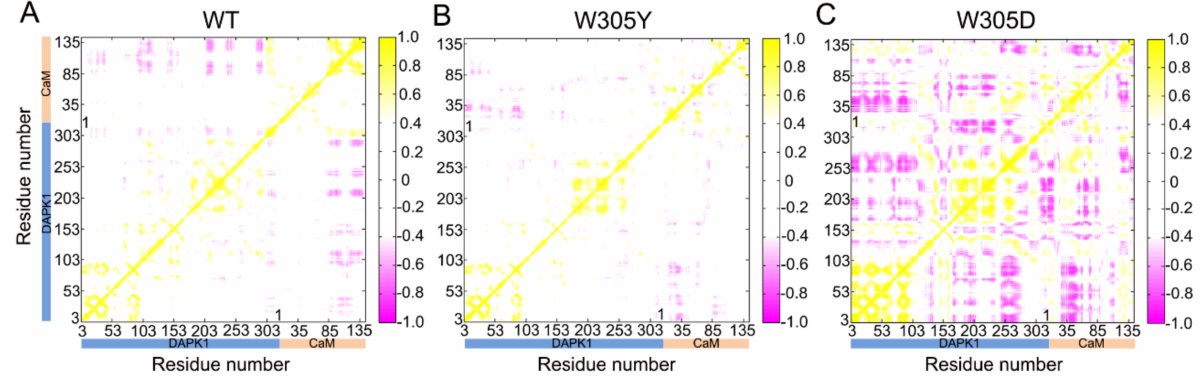
Figure 3. The dynamical cross-correlation matrix (DCCM) plot of the WT ( A ), W305Y ( B ), and W305D ( C ) systems. Anti-correlated/correlated motions with absolute values <0.4 are ignored for clarity and shown in